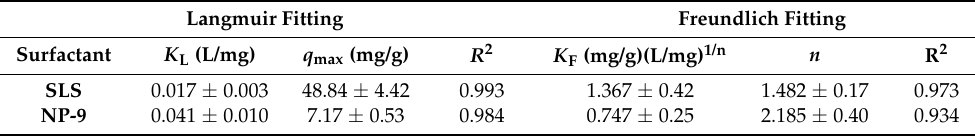
Table 2. Langmuir and Freundlich fitting parameters for SLS and NP-9 adsorption onto CuO NPs. Langmuir Fitting